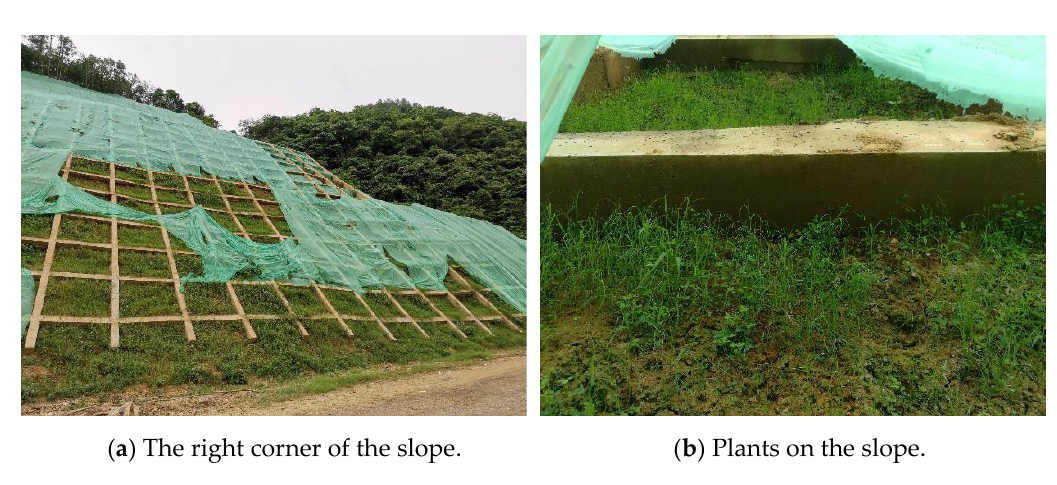
Figure 16. The borrowed soil.